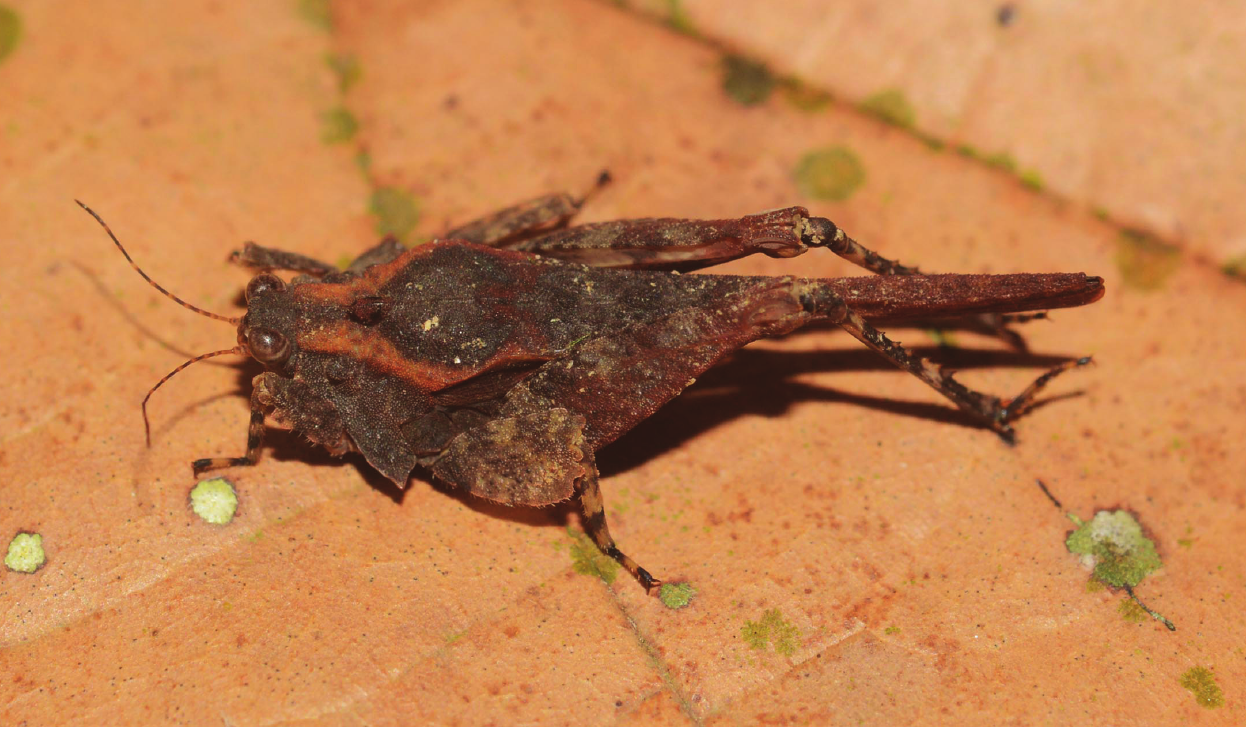
Fig. 10. Live Eomorphopus antennatus female from Brazilian Amazon.